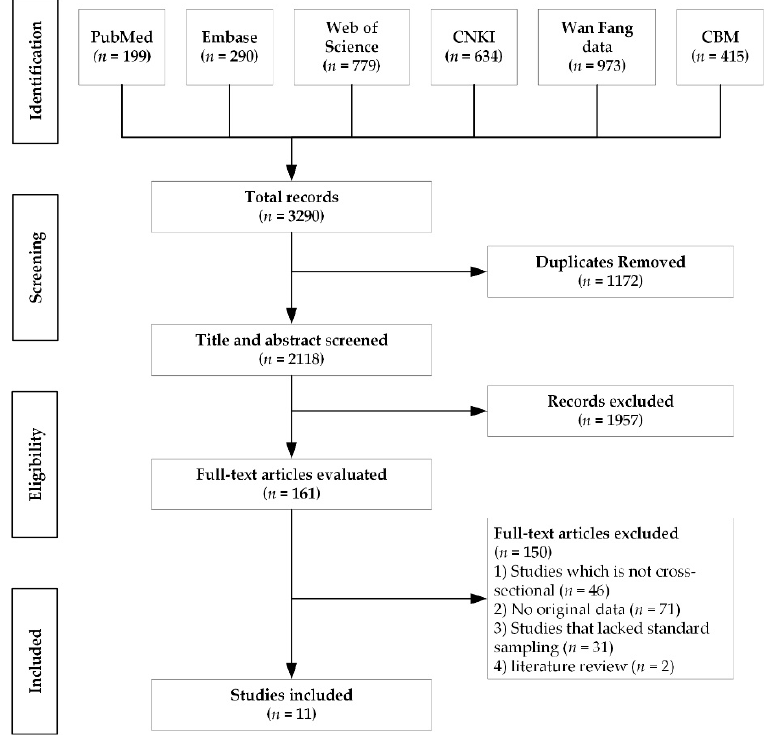
Figure 1. Flow diagram of study selection.